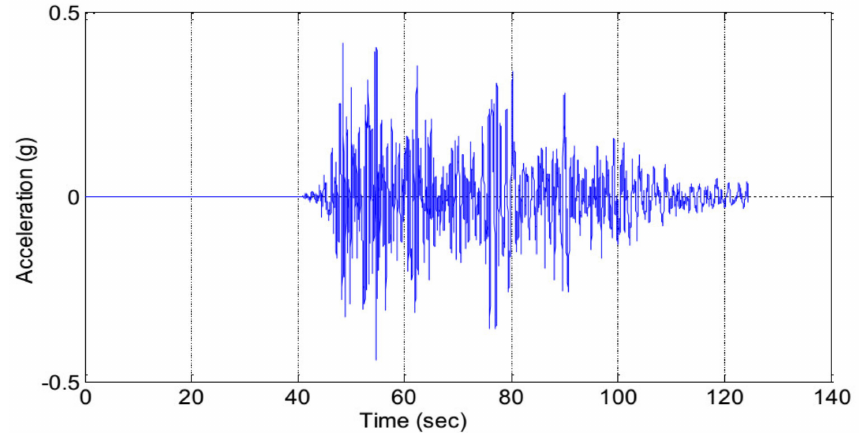
Figure 11. The acceleration time history of the Chi-Chi earthquake measured at the TCU 078 station (PEER Data